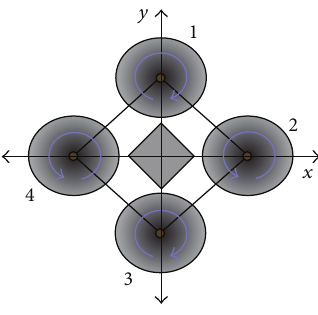
Figure 1: Scheme of quadrotor’s rotor rotation.